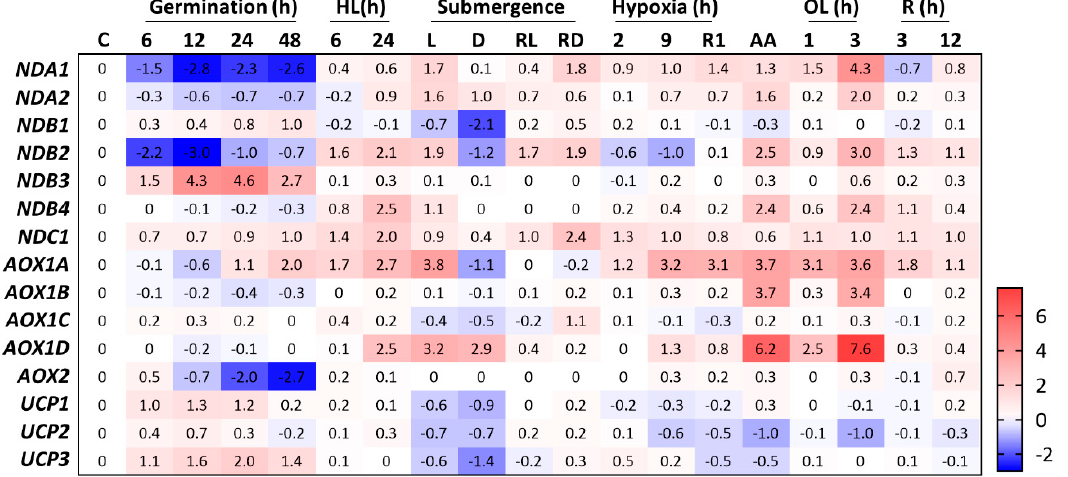
Figure 2. Relative expression of the plant OXPHOS bypasses during germination, abiotic stresses, and chemical treatments. Gene expression data were obtained from the GENEVESTIGATOR database [18]. Original datasets used to build this heatmap were obtained from the Gene Expression Omnibus (GEO) within the National Center for Biotechnology Information (NCBI) database under the following accessions numbers: germination (GSE30223), high light (HL, GSE111062), waterlogging (SRP120444), hypoxia (GSE9719), antimycin (AA, GSE36011), oligomycin (OL, GSE38965), and rotenone (R, E-MEXP-1797). Germination, high light, hypoxia, oligomycin, and rotenone treatments are displayed as hours (h) under the respective treatment. Relative expression is expressed as the log 2 fold-change compared to untreated plants (C) within each condition. Data are not comparable between distinct experiments. For definitions of gene symbols and for a complete description of the gene names, please see Table S1. L: light, D: dark, RL: recovery of light-submerged plants, RD: recovery of dark-submerged plants, R1: 1 h